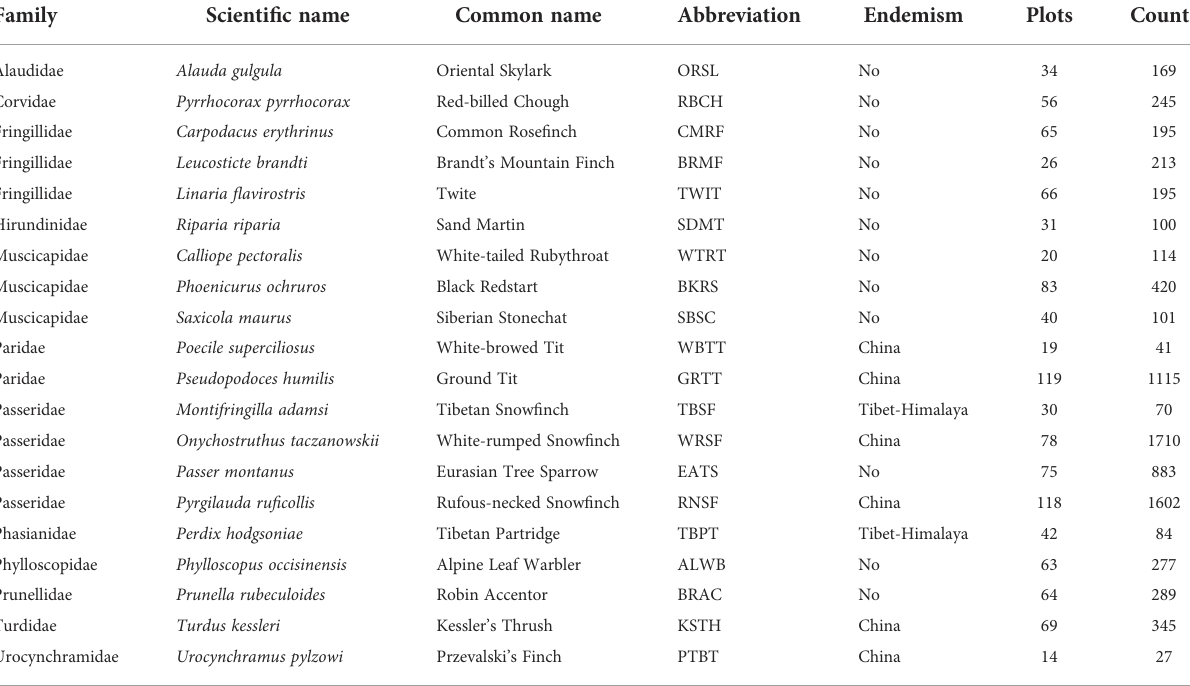
TABLE 1 List of the 20 common and endemic bird species used for data analyses, with their distribution status shown in column Endemism, the total number of plots where the species was recorded shown in column Plots, and the total recorded abundance throughout the six replicates shown in column